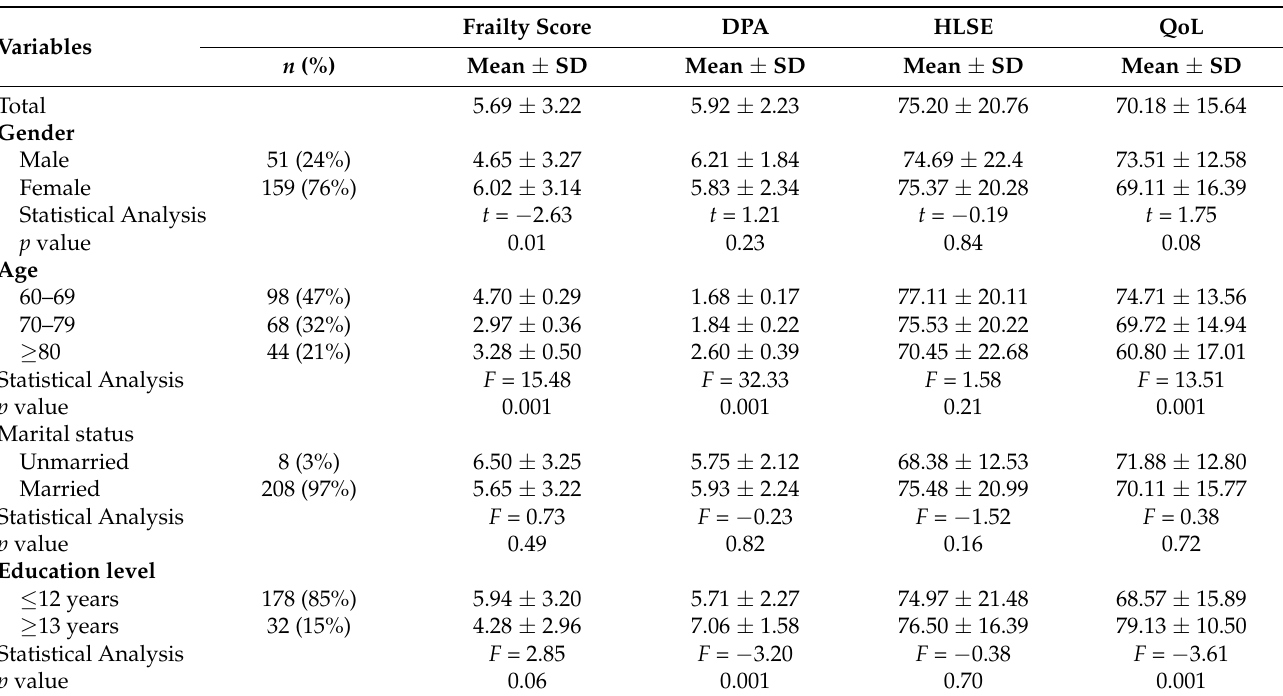
Table 1. Descriptive analysis and differences in frailty score, DPA, HLSE, and quality of life with different sociodemographic characteristics (N = 210).